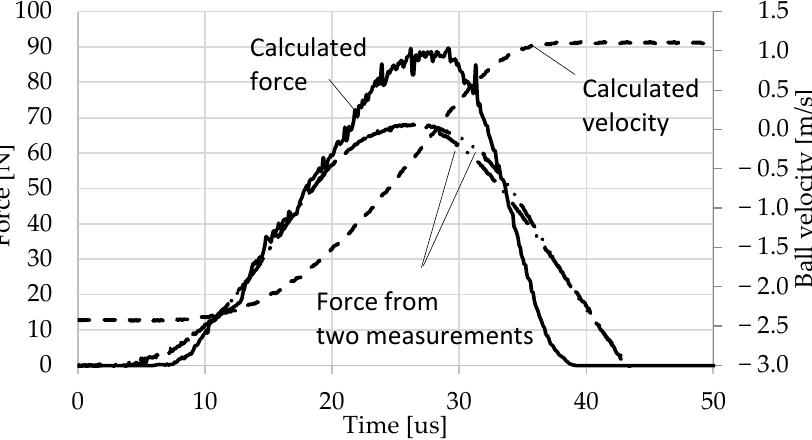
Figure 13. The contact force and the ball velocity obtained from the FEM simulation and the maximum impact force measured with the produced sensor.